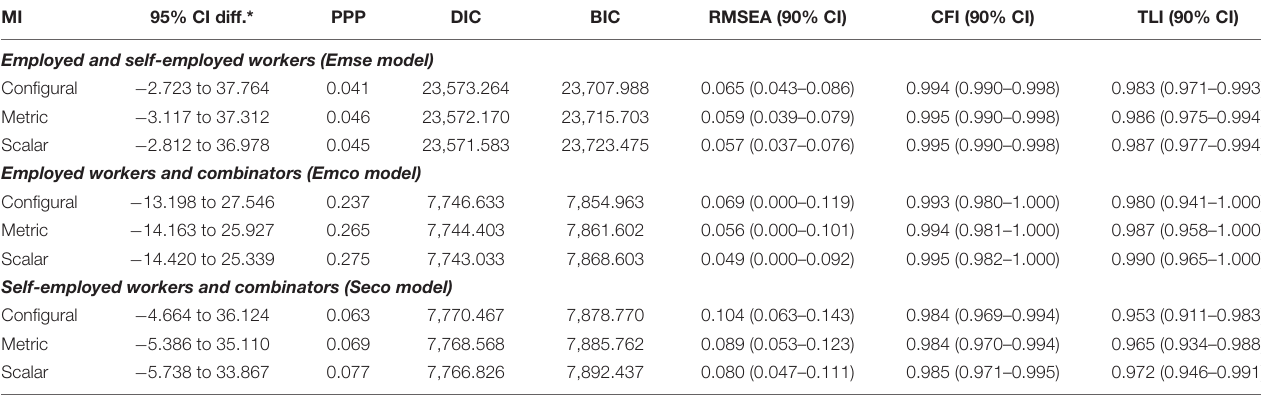
TABLE 6 | Measurement invariance analyses: Sleep